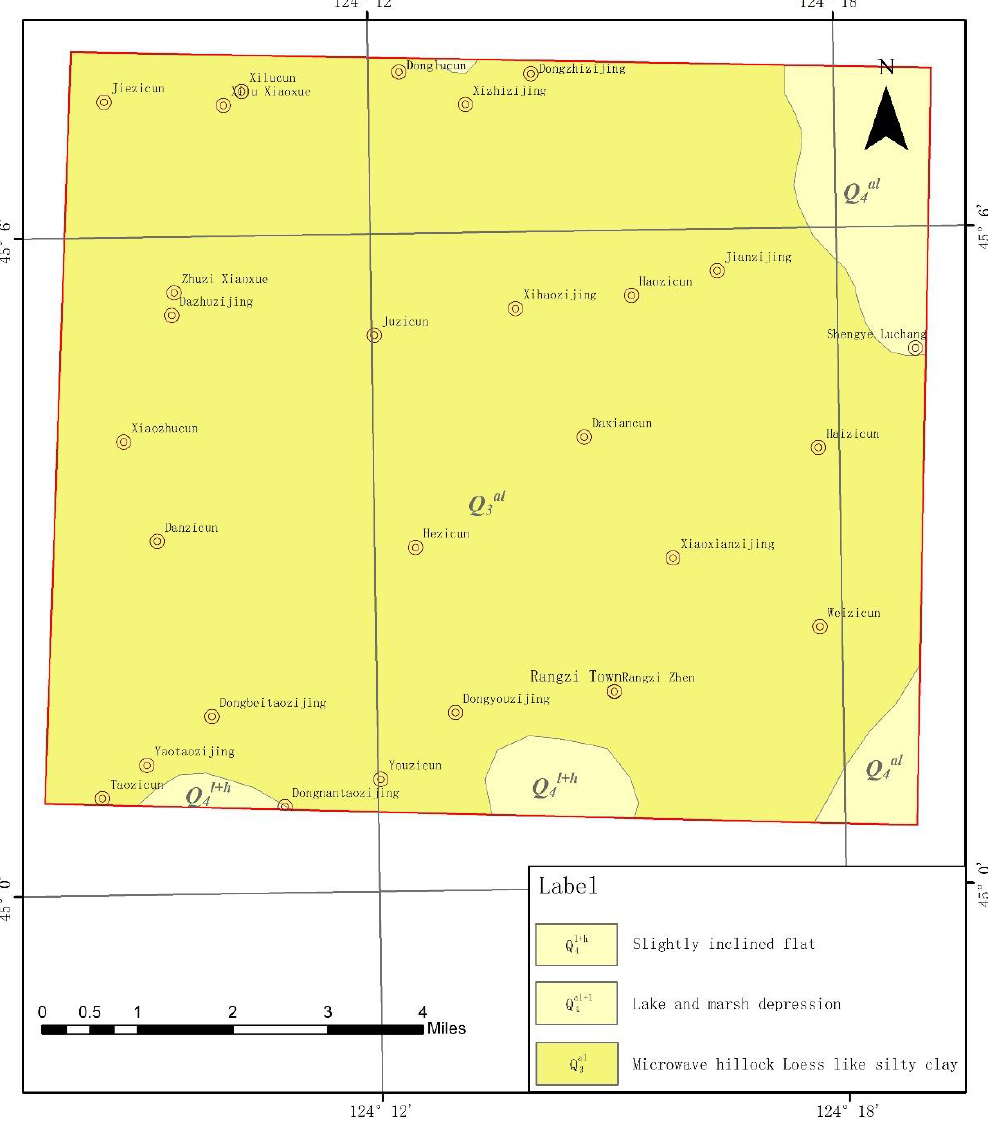
Figure 2. Geomorphological map of the study area.